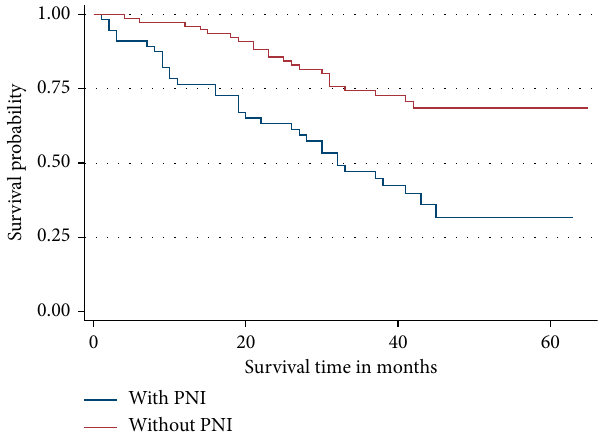
Figure 6: Overall survival by perineural invasion (PNI). Patients with PNI had a high tendency of dying than those without PNI, although the difference was not statistically significant.